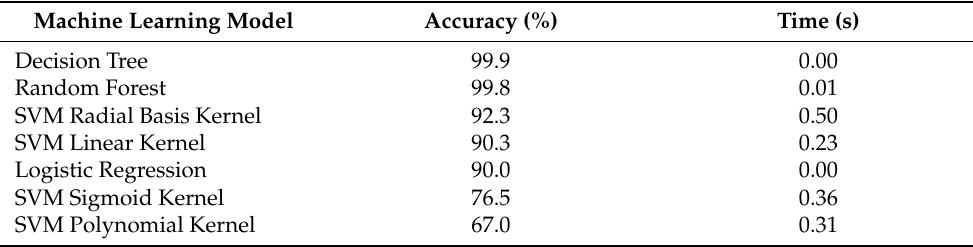
Table 2. Accuracy Score and Computational Time of Machine Learning Classifier